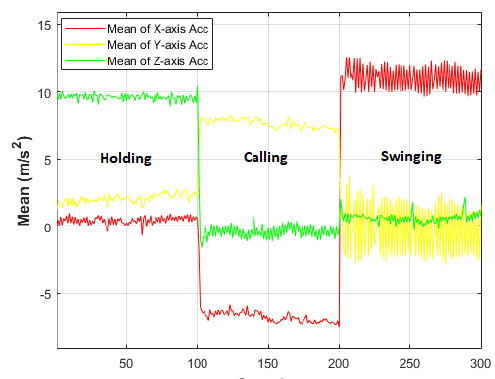
Figure 11. The mean of accelerations with three smartphone modes while pedestrian is walking